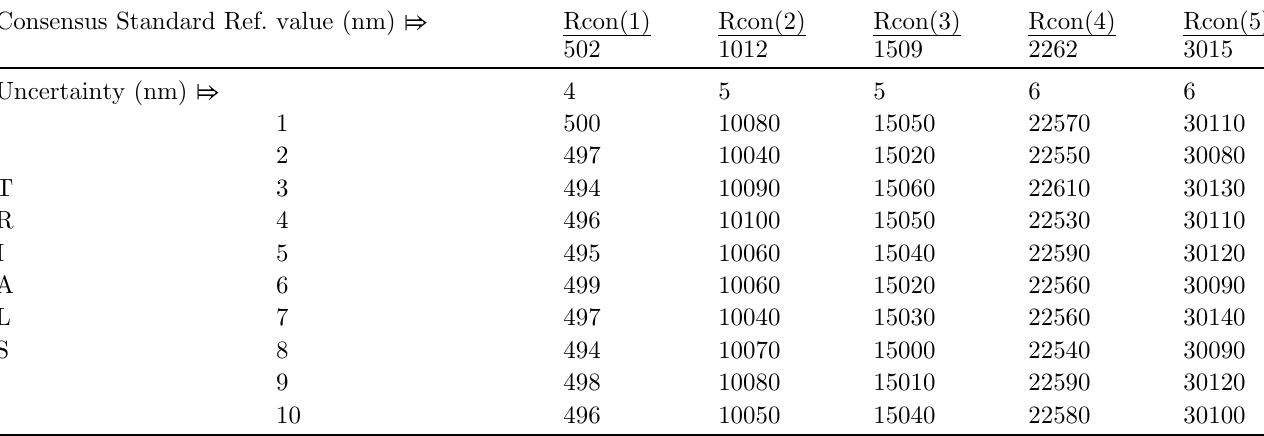
Table 12. Example 6. FAC-1; measurement system D; linearity study.